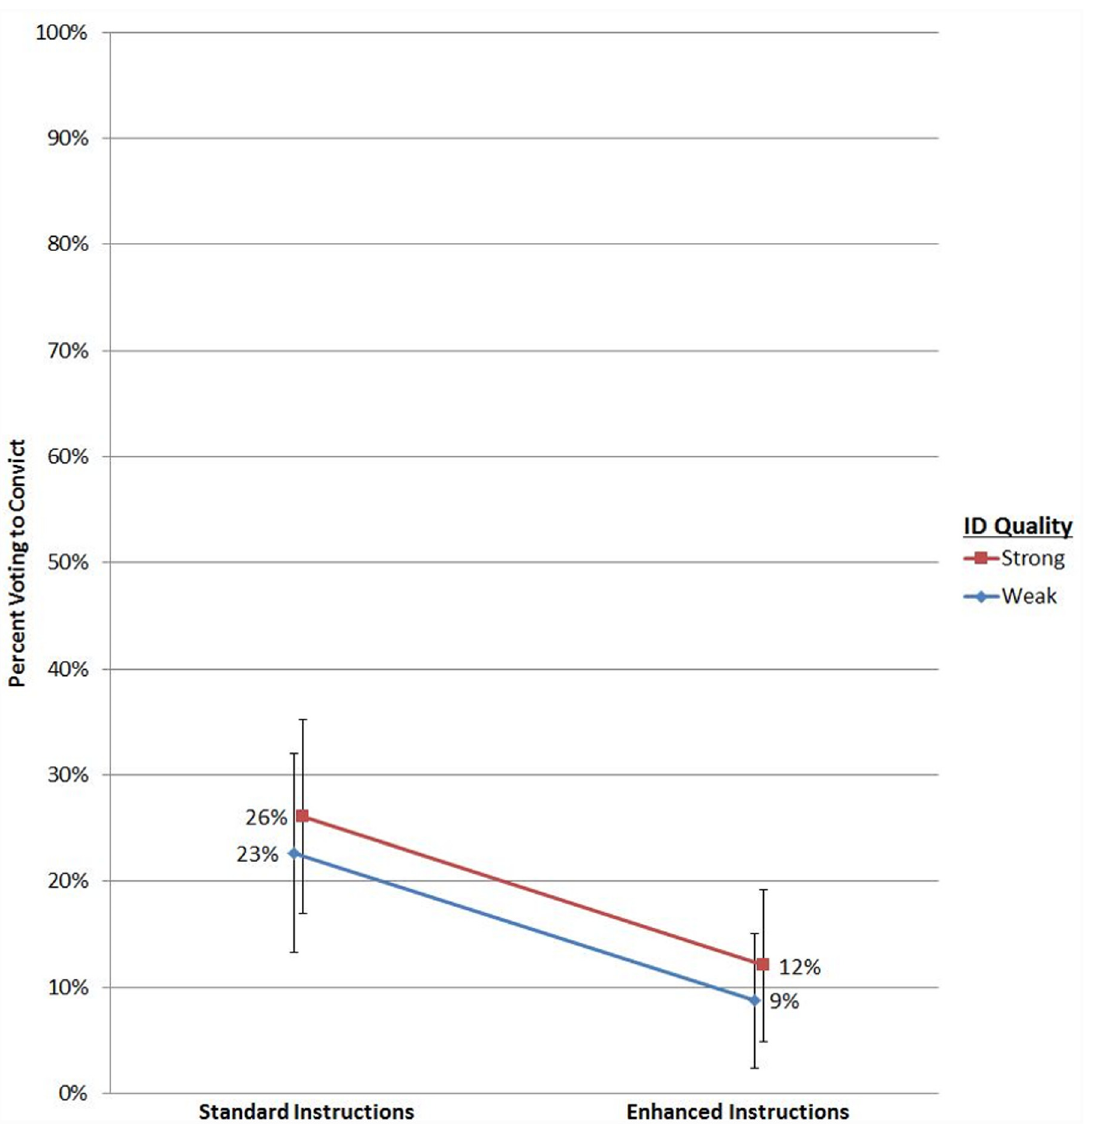
Fig 1. Proportion of Guilty verdicts (and 95% confidence intervals) by Instruction and ID